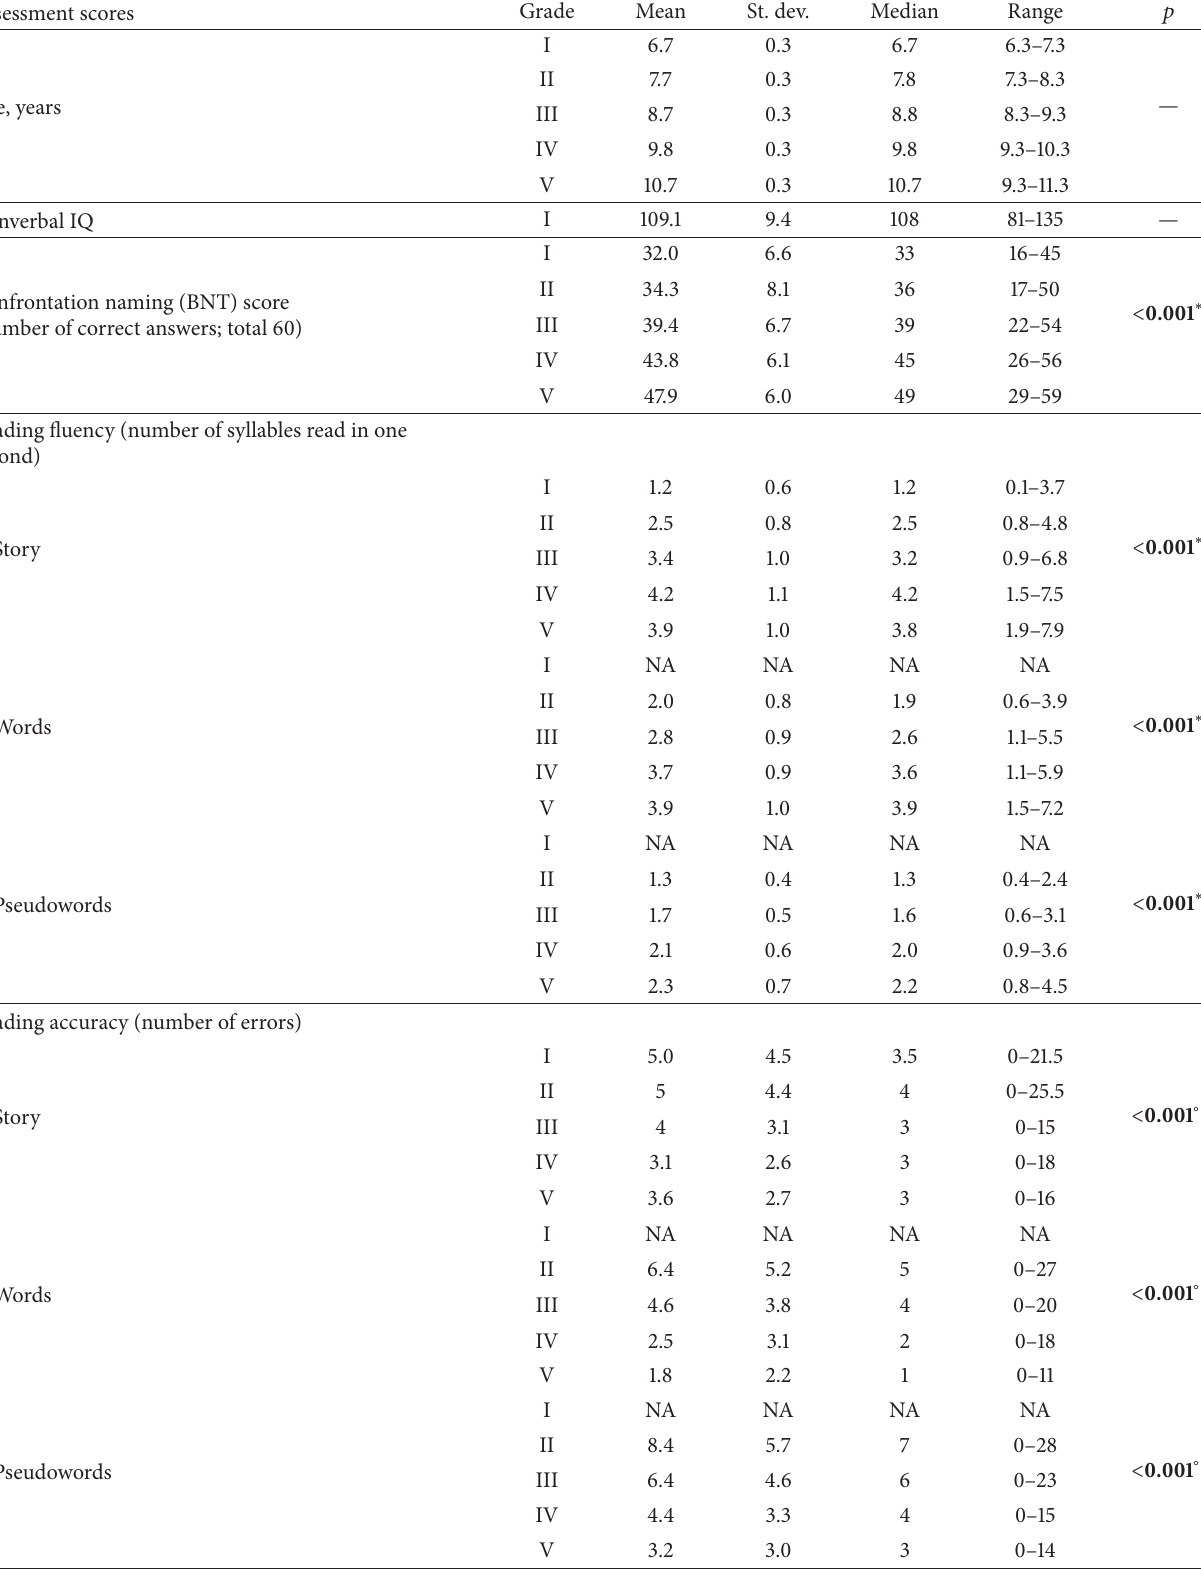
Table 2: Age and assessment scores at the end of each grade of the 126 participants included in the analysis. NA = not administered because word and pseudoword reading tests are available only from the second year onwards. Paired samples 𝑡 -tests ( ∗ ) and Friedman test ( ∘ ) were used in order to verify test scores improvement from year to